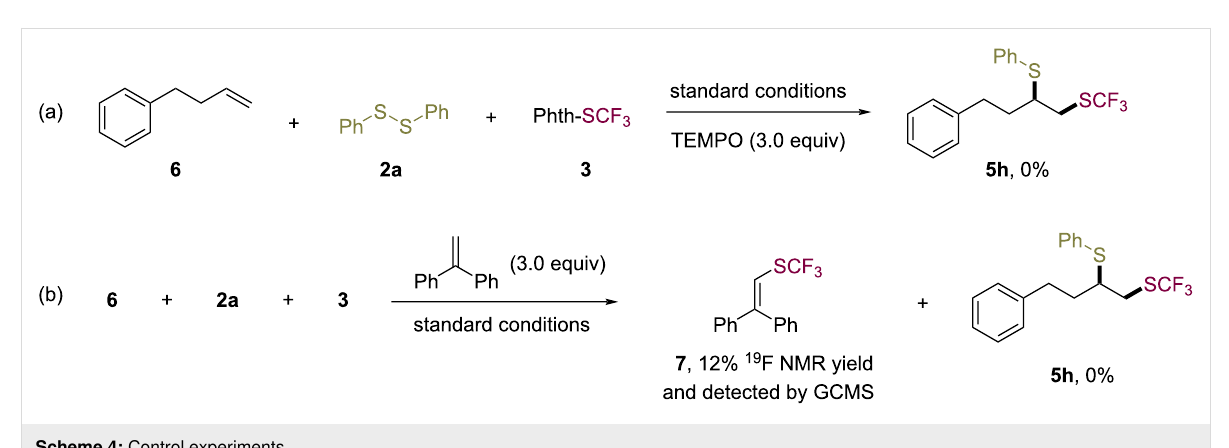
Scheme 3: Substrate scope of unactivated alkenes.